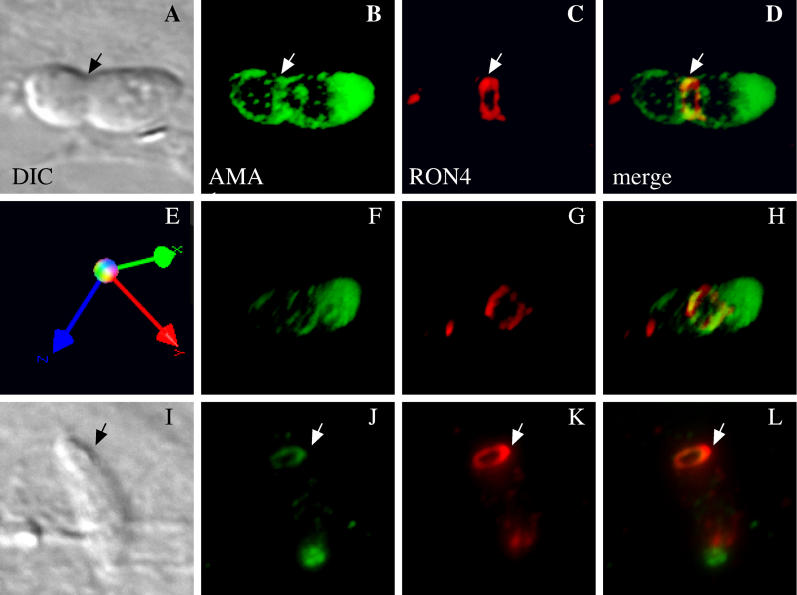
Localization of TgAMA1 and RON4 During InvasionTachyzoites were allowed to invade following a potassium shift as for Figure 4. DICA, E, and I) and deconvolution IIF were then used to image formaldehyde-fixed parasites as described in Figure 3, except that the monolayers were permeabilized at the outset and a mAb specific for the cytoplasmic tail of TgAMA1 (CL22) was used in place of anti-SAG1. The images shown here are three-dimensional reconstructions from forty 0.1-μm sections.(A–D) show a wild-type parasite that is about 40% inside the host cell (the outside portion shows a bright, posterior cap of CL22 staining). (E) shows the axis of rotation for the reconstruction, and the new view of the IIF images present in (B–D) are shown in the corresponding panels (F–H). Images (I–L) show a ΔAMA1/AMA1-myc parasite with low surface AMA1 signal (no posterior cap) that is about 80% invaded into its vacuole. The MJ is indicated by an arrow.